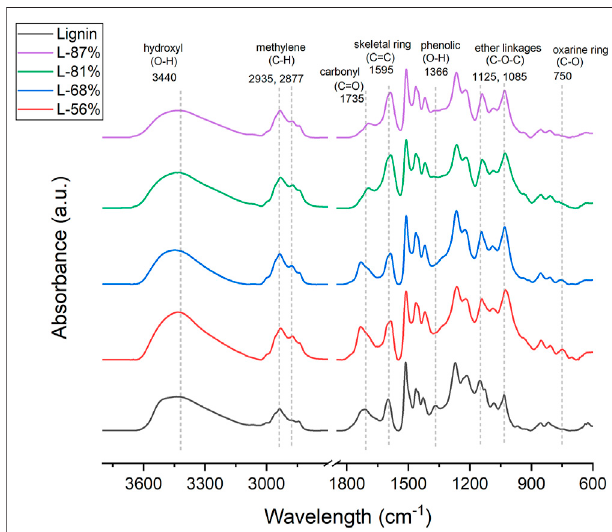
FIGURE 2 | FTIR spectra of lignin aerogels with different crosslinker-to- lignin ratios corresponding to 44, 68, 81, and 87 wt% of lignin (all spectra normalized with skeletal vibration band of lignin at 1,510 cm − 1 ).